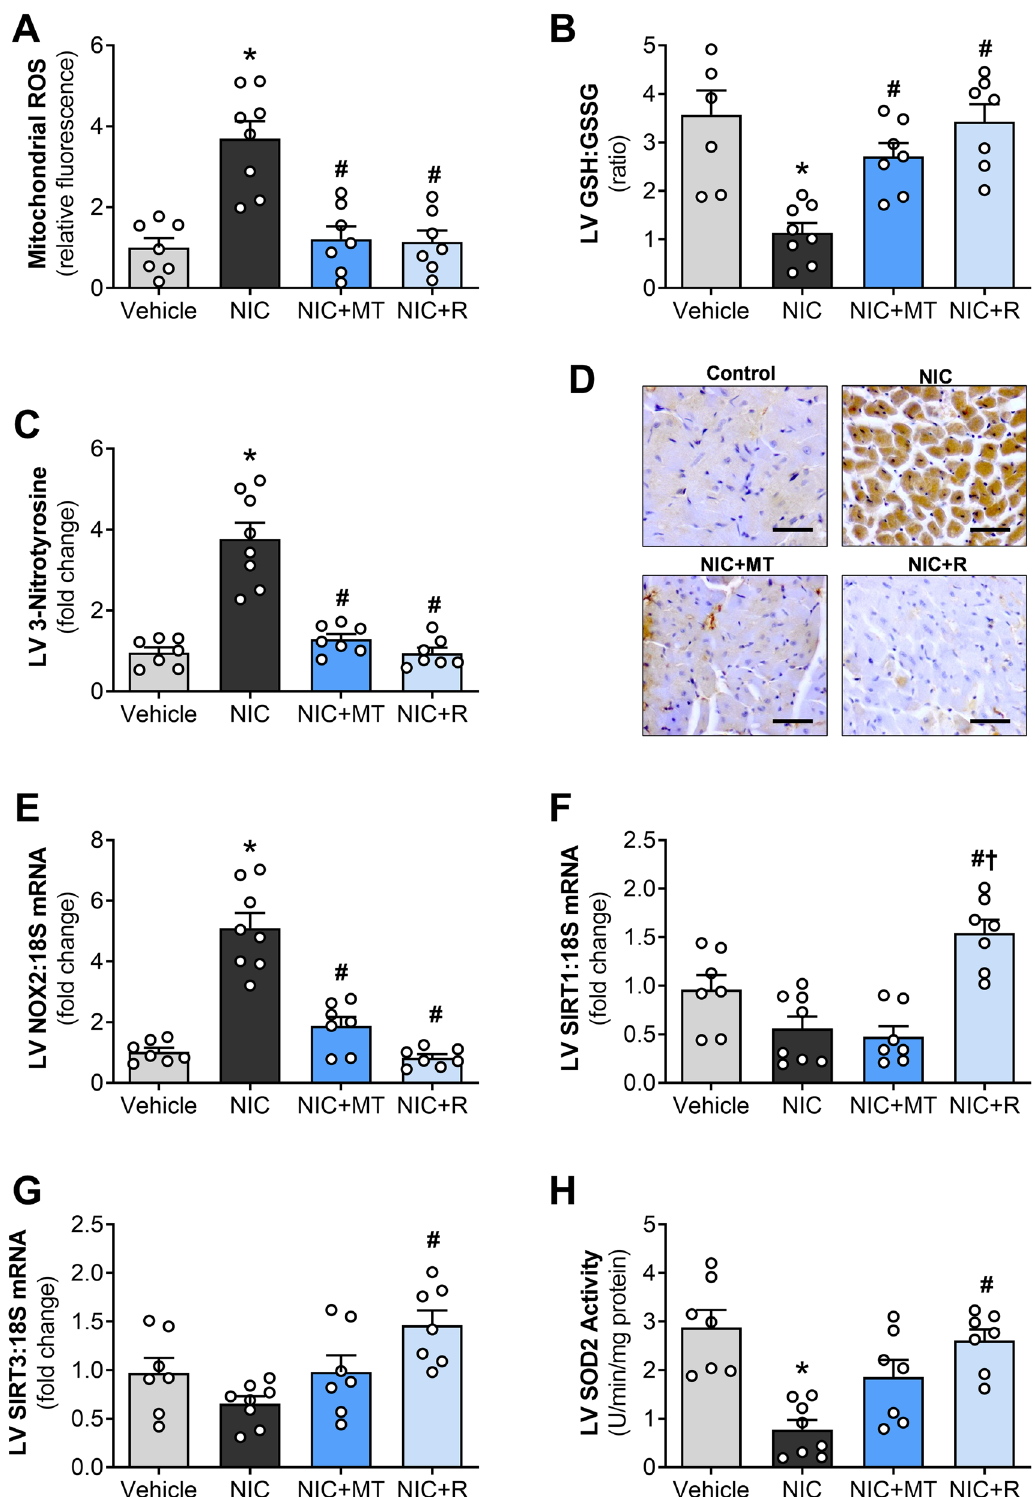
Figure 2. Impact of mitoTEMPO and resveratrol on nicotine-induced mitochondrial ROS-driven oxidative stress in rat hearts. ( A ) Mitochondrial ROS production, ( B ) GSH:GSSG ratio, ( C ) LV 3-nitrotyrosine content, ( D ) Representative images of LV sections immunostained with antibodies targeting 3-nitrotyrosine (scale bar = 50 µm), ( E ) LV gene expression of NOX2 subunit of NADPH oxidase, ( F ) LV gene expression of SIRT1, ( G ) LV gene expression of SIRT3 and ( H ) LV SOD2 activity. All values are given as mean ± SEM for n = 7–8/ group; * p < 0.05 versus vehicle group; # p < 0.05 versus NIC group and † p < 0.05 versus NIC + MT group using one-way ANOVA with Tukey post